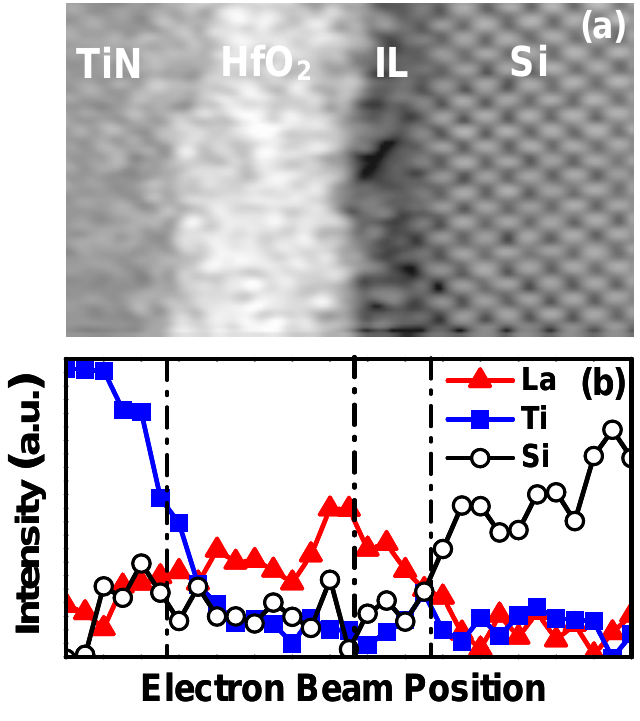
Figure 1. ( a ) Z-contrast image and ( b ) corresponding Electron Energy-Loss Spectroscopy (EELS) profiles (La, Ti, and Si) of the SiO anneal (after